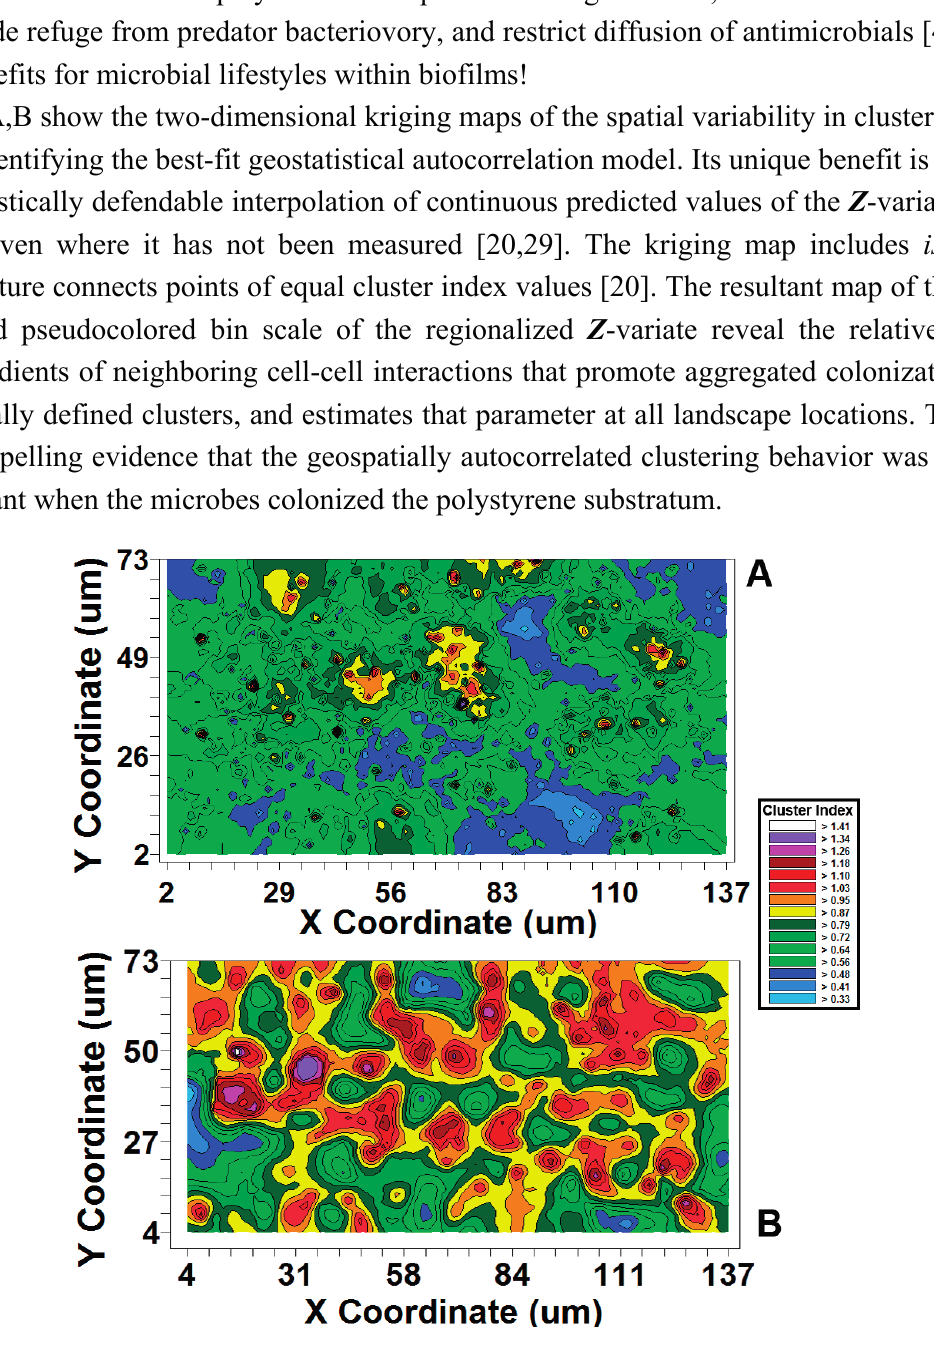
Figure 5. Kriging maps of the spatially autocorrelated intensity of aggregated colonization behavior of the microbial assemblages in the freshwater biofilm landscapes developed on ( a ) plain glass and ( b ) polystyrene. The legend shows the stepped scale of pseudocolored bins for the range of CMEIAS cluster index values in each